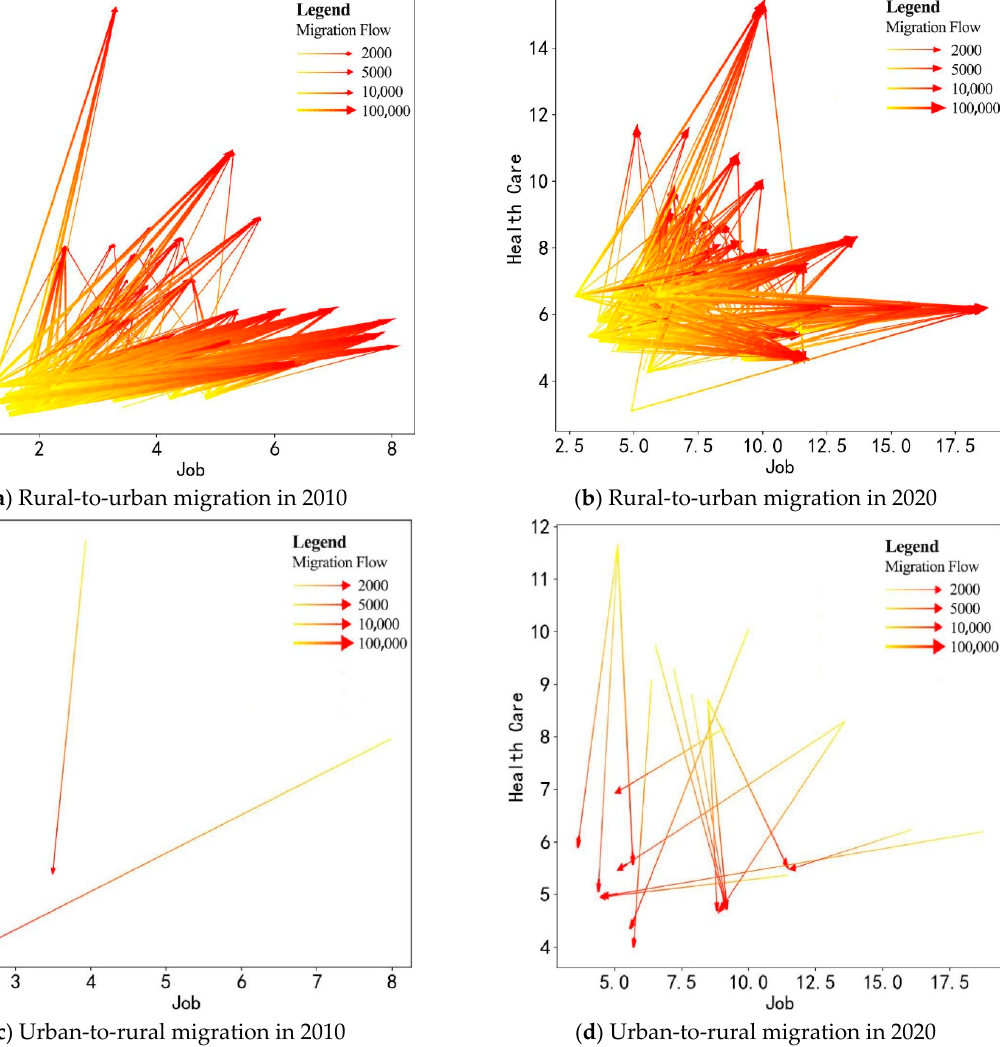
Figure 3. The economic and health care conditions of destinations in 2010 and 2010. People are assigning more importance to living conditions in their migration choices.